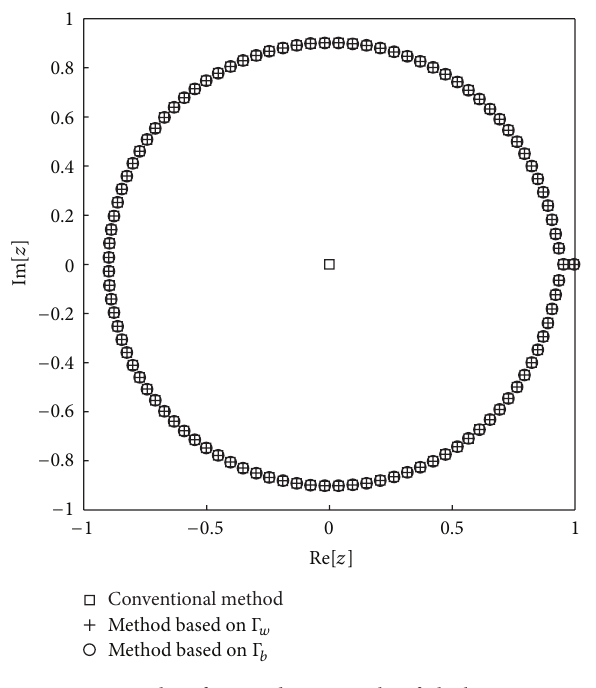
Figure 5: Eigenvalues of vortex lattice model of unsteady flow about the three-dimensional wing— ◻ conventional method, + method based on Γ 𝑤 , and I present